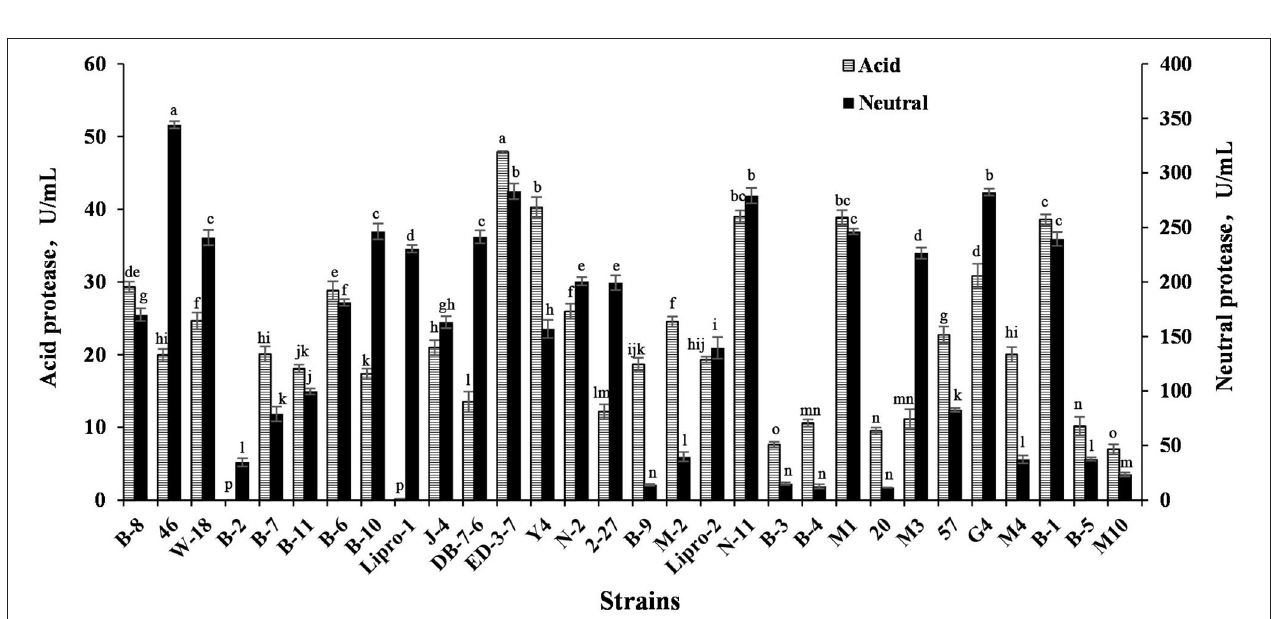
FIGURE 2 | Acid protease and neutral protease production ability of strains. Values are expressed as averages ± SD. Different letters indicate significant differences ( P < 0.05) among groups.